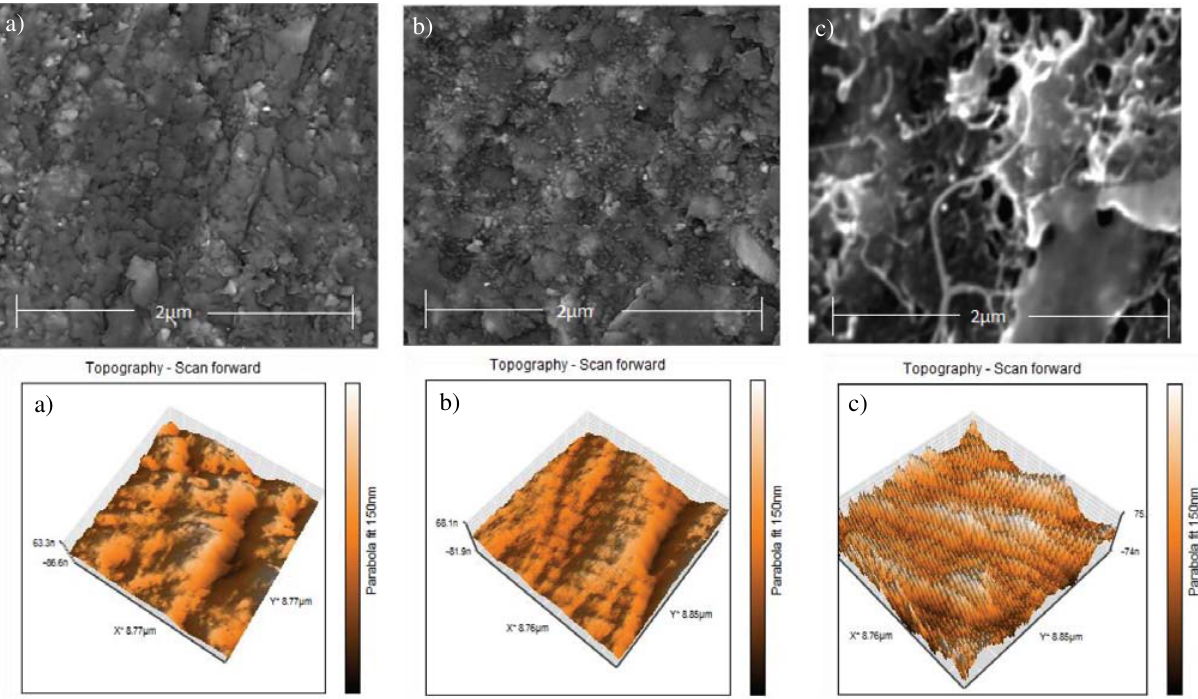
Figure 2 . SEM (top) and AFM (down) images of bare GC (a), PDB/GC (b) and PDB/MWCNTs-GC (c) electrodes